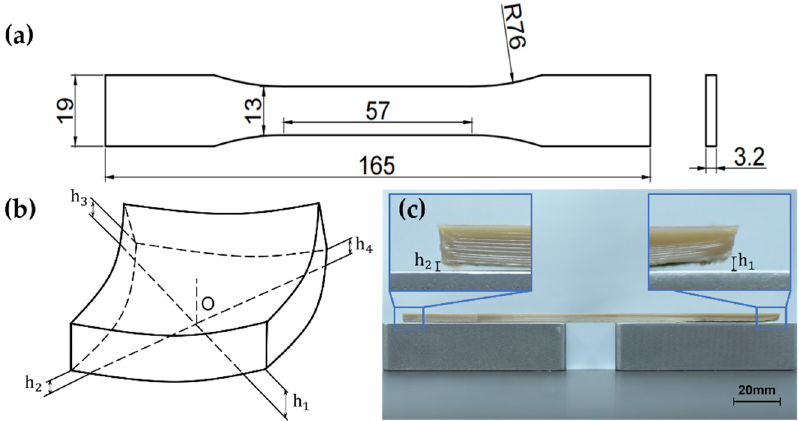
Figure 1. Tests and measurement of the product: ( a ) shapes and dimensions of the tensile sample; ( b ) measurement index to evaluate the warpage deformation; ( c ) warpage measurement methods based on the picture.